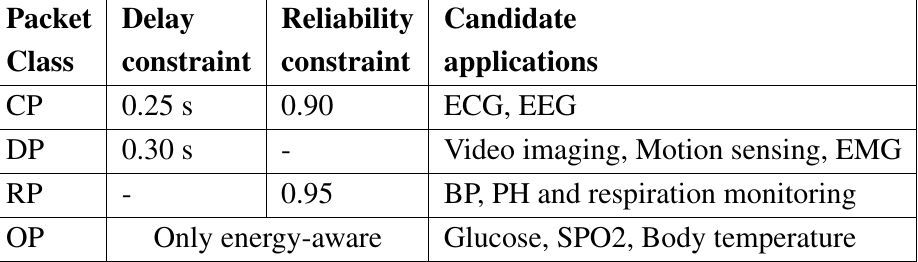
Table 2. QoS requirements for different